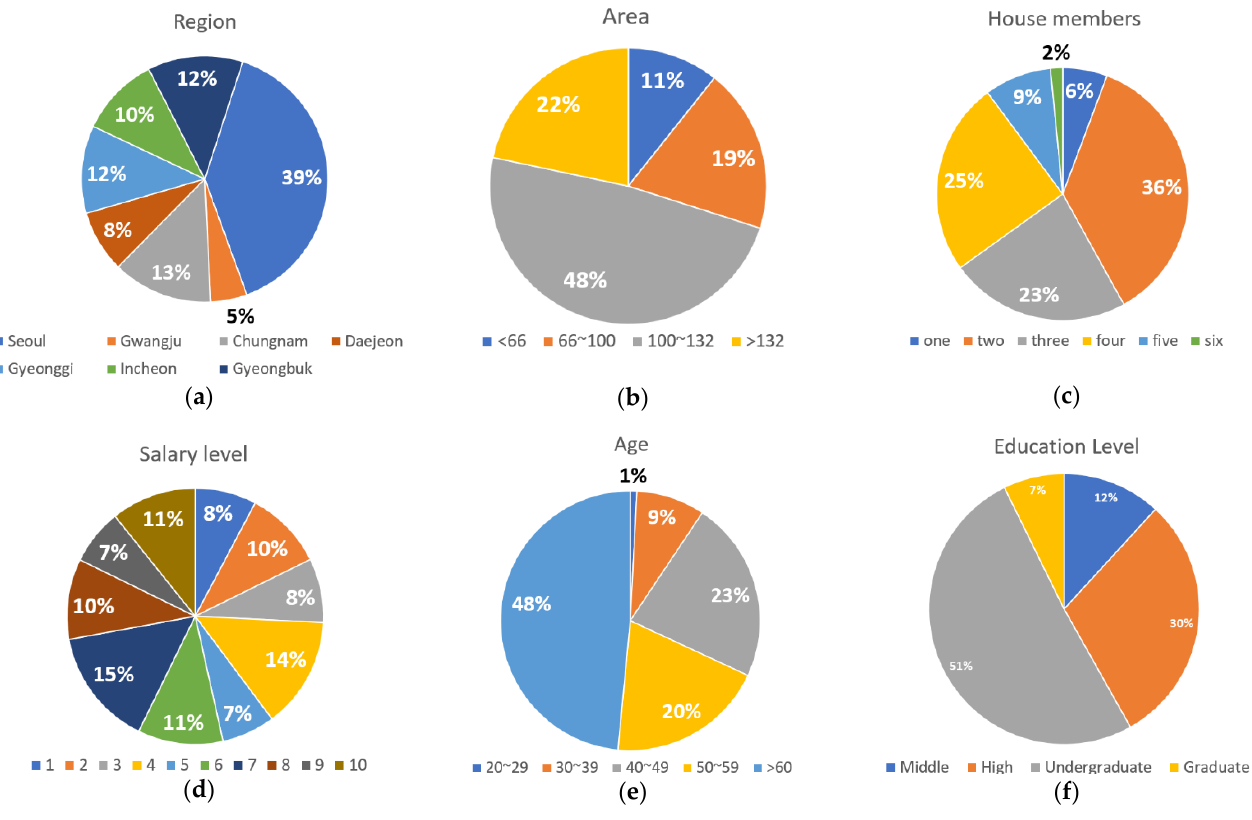
Figure 2. Distribution of customers by region and demographic